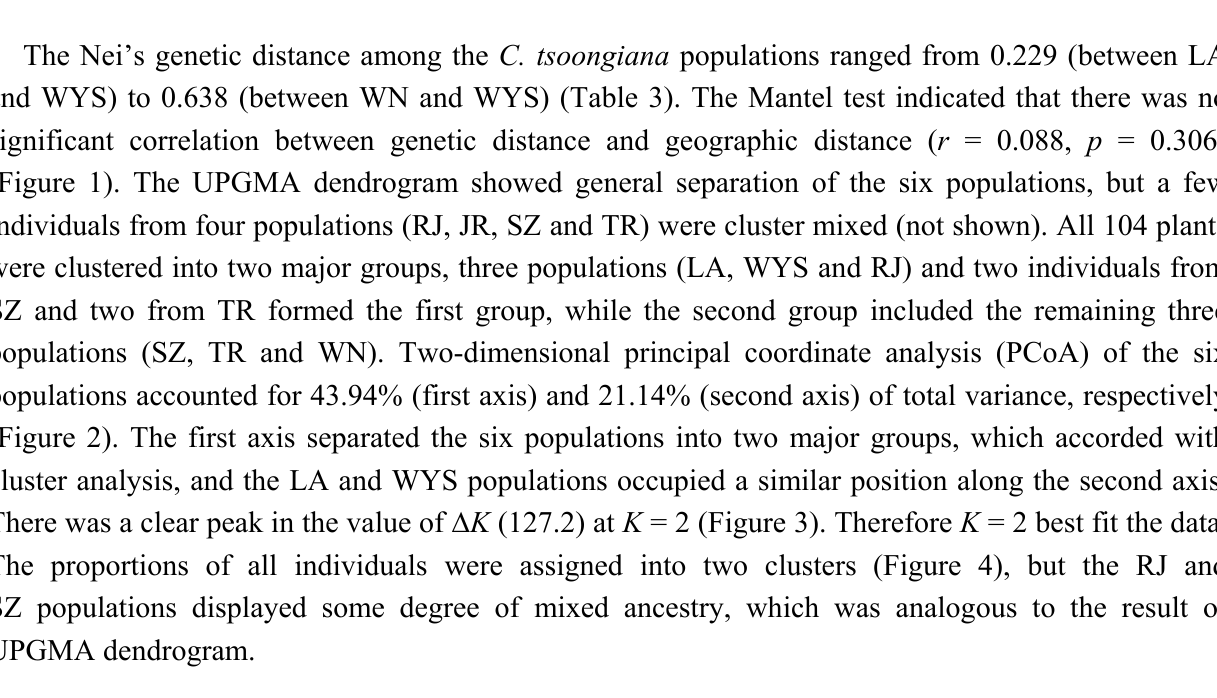
Table 3. Nei’s original measures of genetic identity (above diagonal) and genetic distance (below diagonal) among the populations of C. tsoongiana